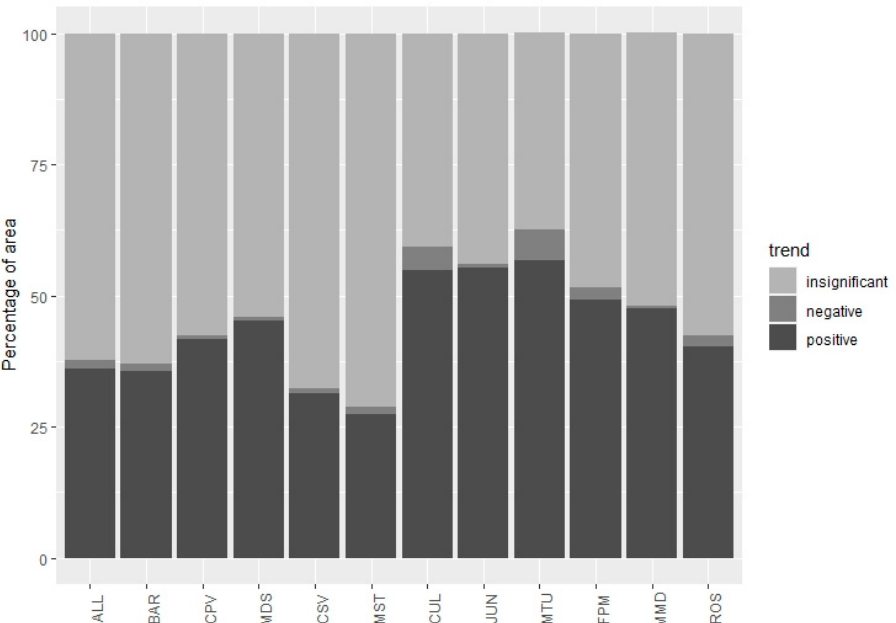
Figure 4. Proportion of trend type in the entire study area and the individual land cover classes. ALL: entire study area; BAR: barren land; CPV: cushion plant vegetation; MDS: mountain deserts; CSV: cryophytic and subnival vegetation; MST: mountain steppes; CUL: cultivated land; JUN: juniper vegetation; MTU: mountain Tugai; FPM: floodplain meadows; MMD: mountain meadows; ROS: Rosaceae scrub. Table 2. Trend type according to land cover class, based on 1100 test plots (100 per land cover class). Land Cover Class